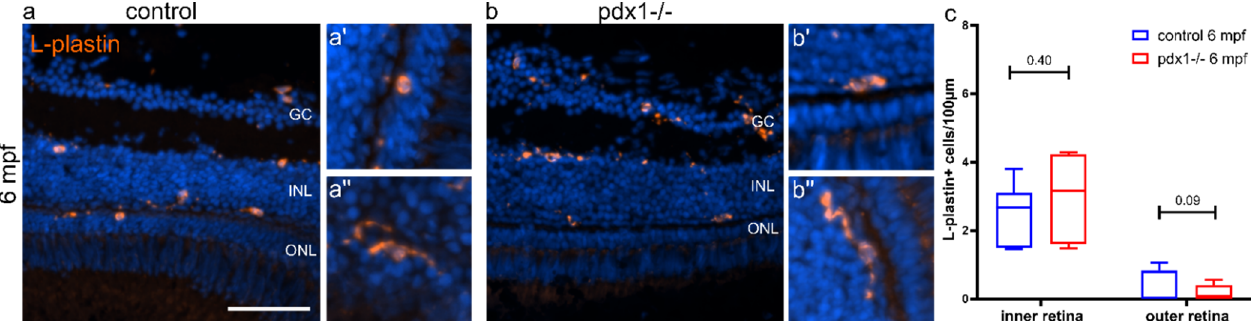
Figure 3. Immunolocalization of immune cells in the retina of control and pdx1 − / − mutant zebrafish. Cryosections of 6 mpf control ( a ) and pdx1 − / − mutant ( b ) retinas stained for L ‐ plastin (orange) and counterstained with DAPI (blue). Close ‐ up images of compact and round ( a’ , b’ ) versus elongated ( a’’ , b’’ ) L ‐ plastin labeled cells found in control ( a’ , a’’ ) and pdx1 − / − mutants ( b’ , b’’ ). ( c ) Quantification of L ‐ plastin positive cells in the inner and the outer retina (for details see Materials and Methods). Box plot extends from 75% to 25%, whiskers showing minimum and maximum, line indicates median, n = 7 controls, 6 pdx − / − . Scale bar: 50 μ m. (GC, ganglion cell layer; INL, inner nuclear layer; ONL, outer nuclear layer;).